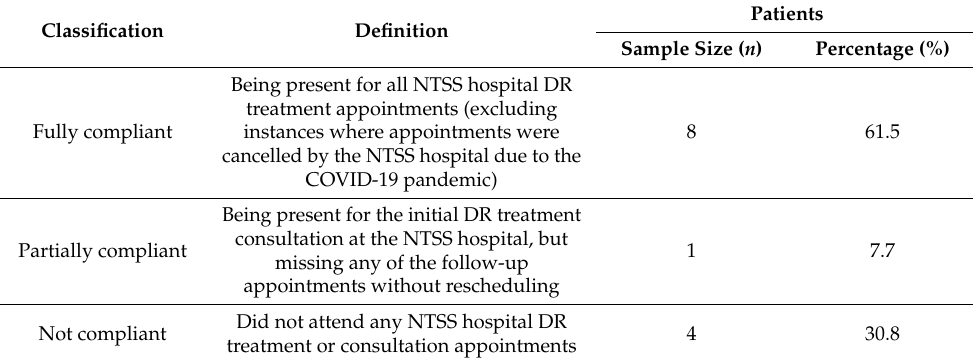
Table 2. Classification of